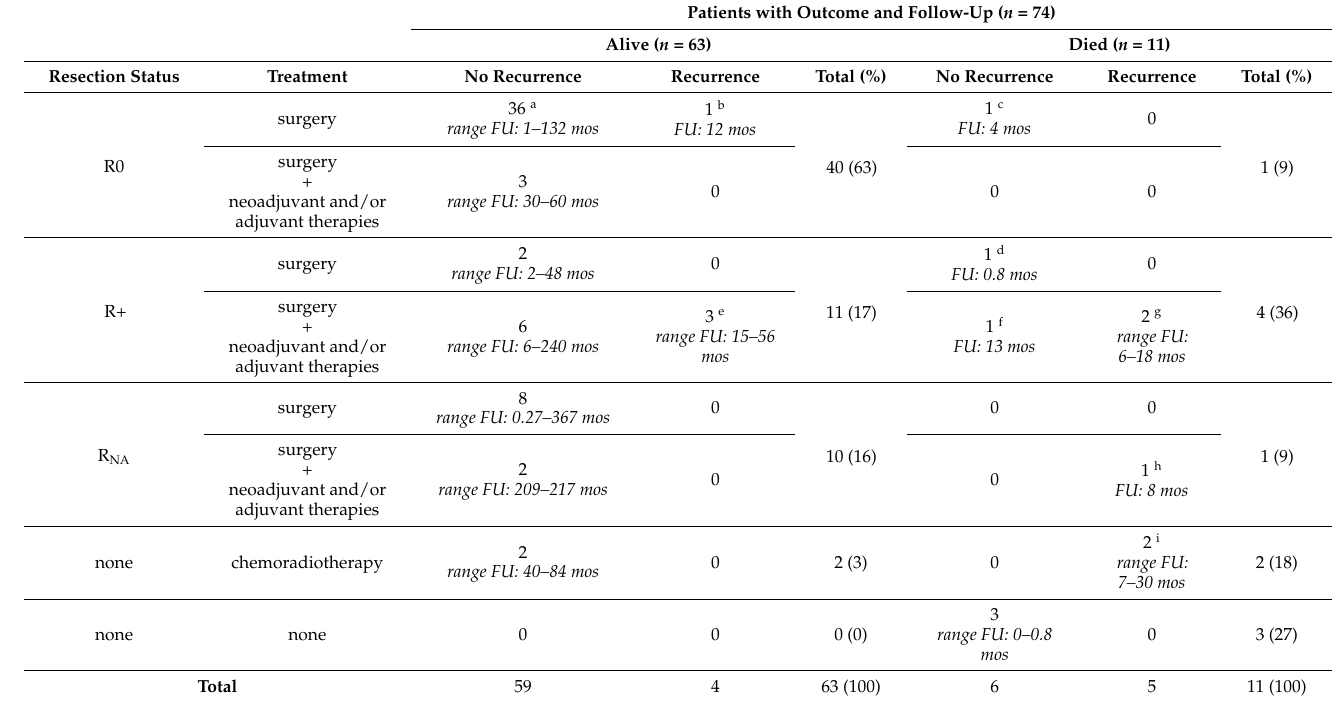
Table 2. Outcome by completeness of